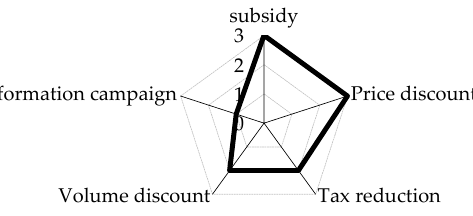
Figure 4. Assessment of measures to increase the use of desalinated seawater for irrigation.